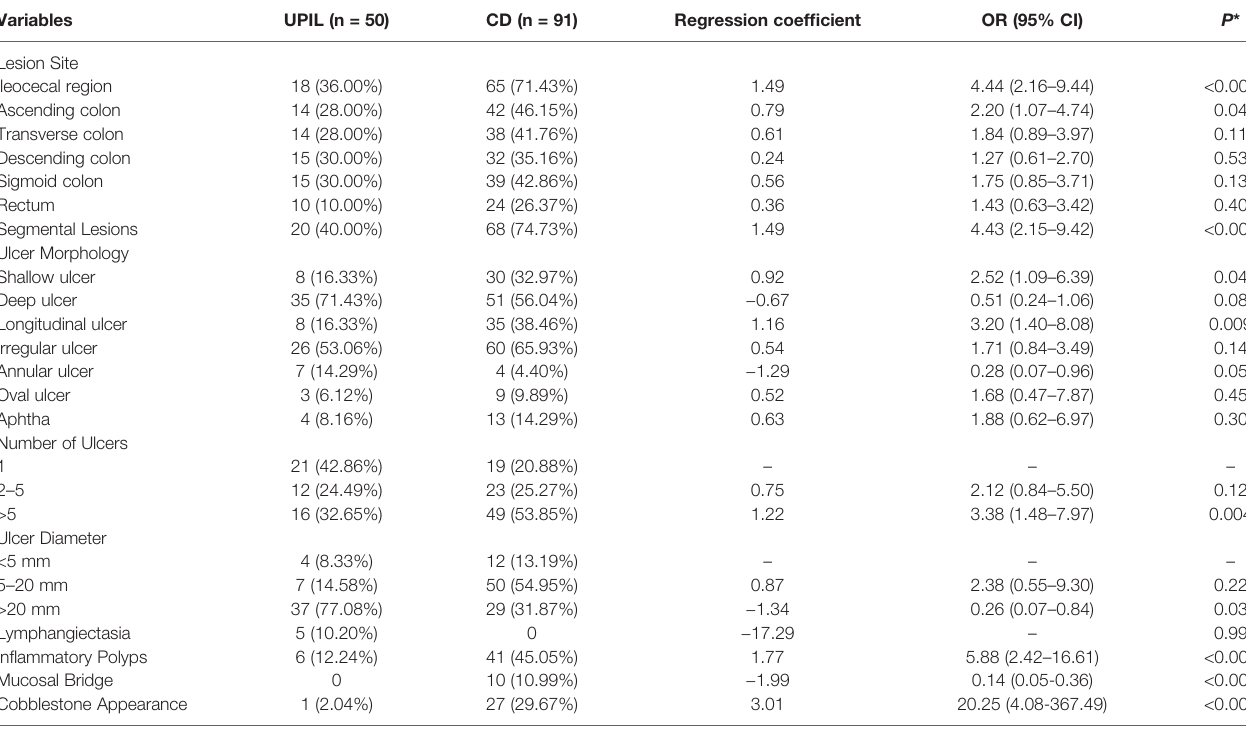
TABLE 4 | Endoscopic Characteristics of Participants with Crohn ’ s disease or Ulcerative Primary Intestinal Lymphoma. Variables UPIL (n = 50) CD (n = 91) Lesion Site Ileocecal region